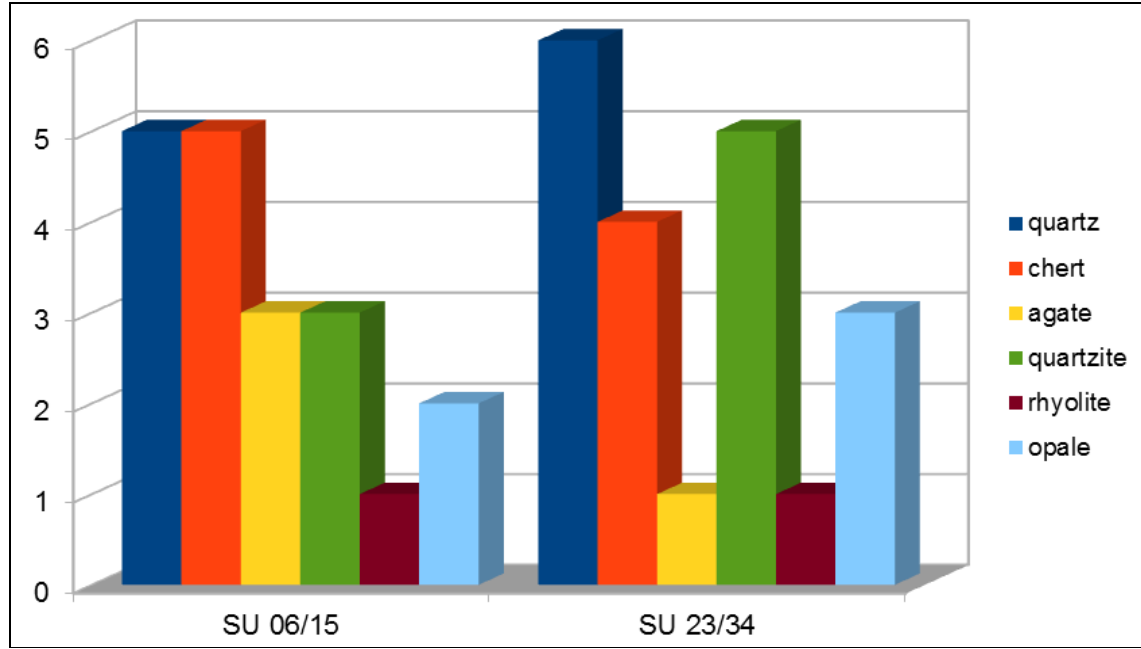
Figure 5. Raw material for each Stratigraphic